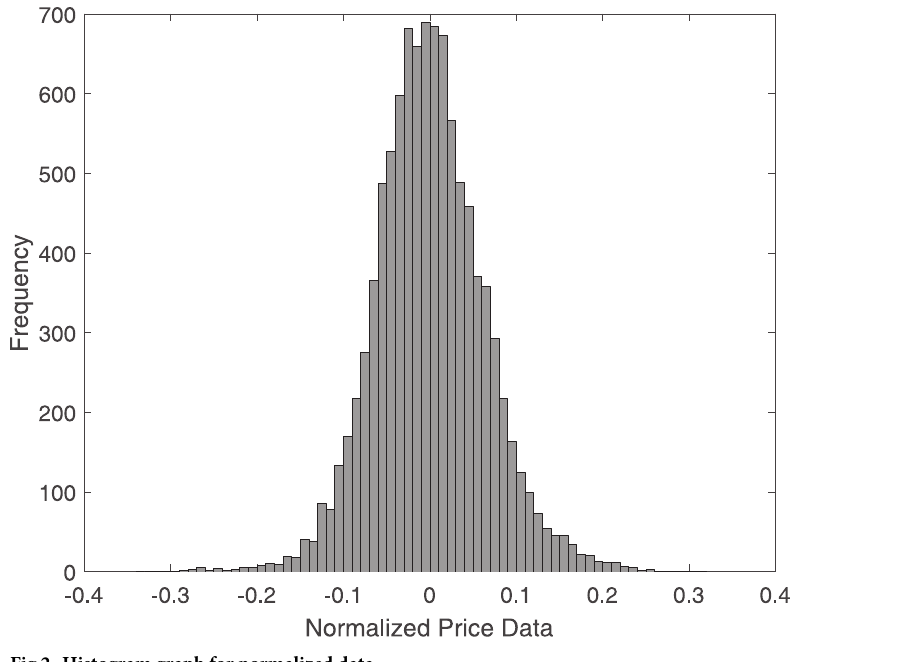
Fig 2. Histogram graph for normalized